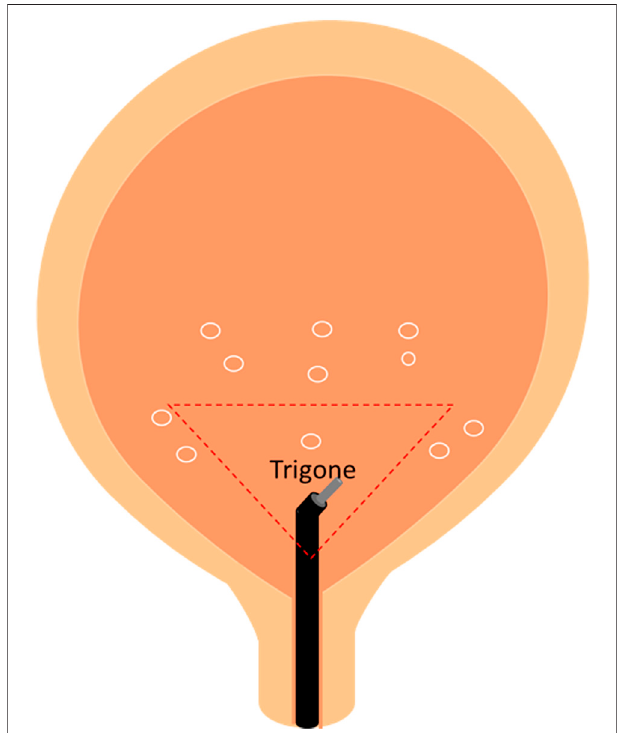
FIGURE 7 | Location of dextrose injection